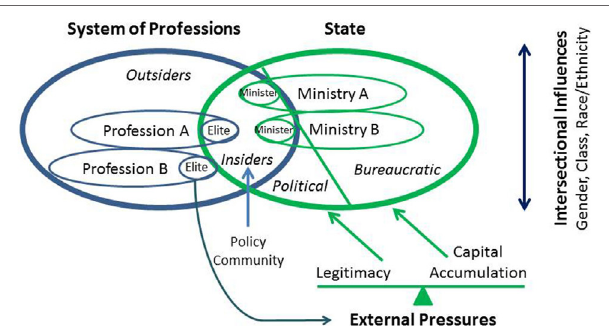
FiGURe 1 | A heuristic conceptual model of profession-state